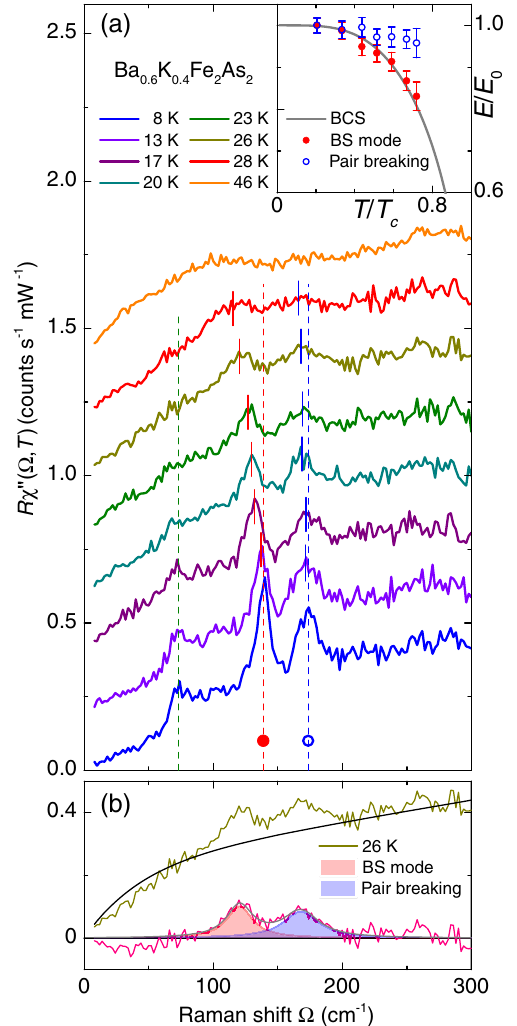
FIG. 1. Temperature dependence of the Raman spectra of Ba 0 K 0 Fe 2 As 2 in B 1 symmetry. (a) The spectra measured g . 6 . 4 above 8 K are consecutively shifted up by 0.2 units. The pair- breaking features (open symbols) and the collective mode (full circles) depend differently on temperature, as shown in the inset (having a suppressed energy of 0). The pair-breaking maximum exhibits a temperature dependence that is different from BCS due to interaction effects [45,46]. (b) The peak energies are deter- mined by fitting the spectra with two Lorentzians and a smooth phenomenological background (black